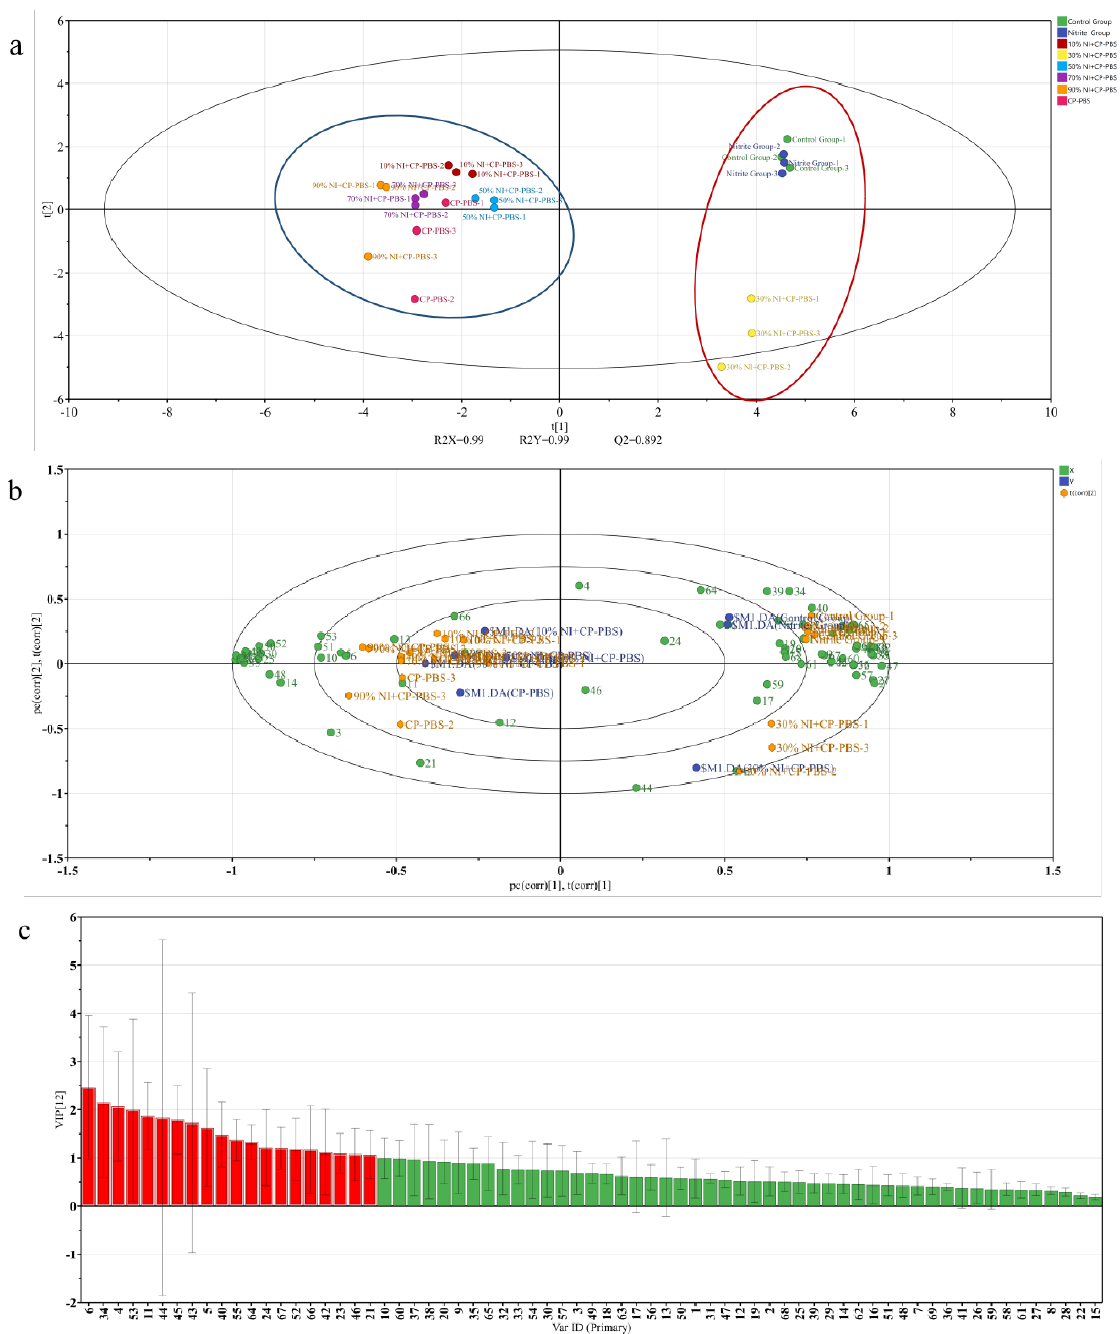
Figure 6. PLS − DA analysis of the volatile compounds during oral processing in the smoked sausage. ( a ) Permutation plot; ( b ) Biplot; ( c ) VIP score. * In Figure 6b,c, the numbers 1 to 69 represent the 69 volatile flavor substances: